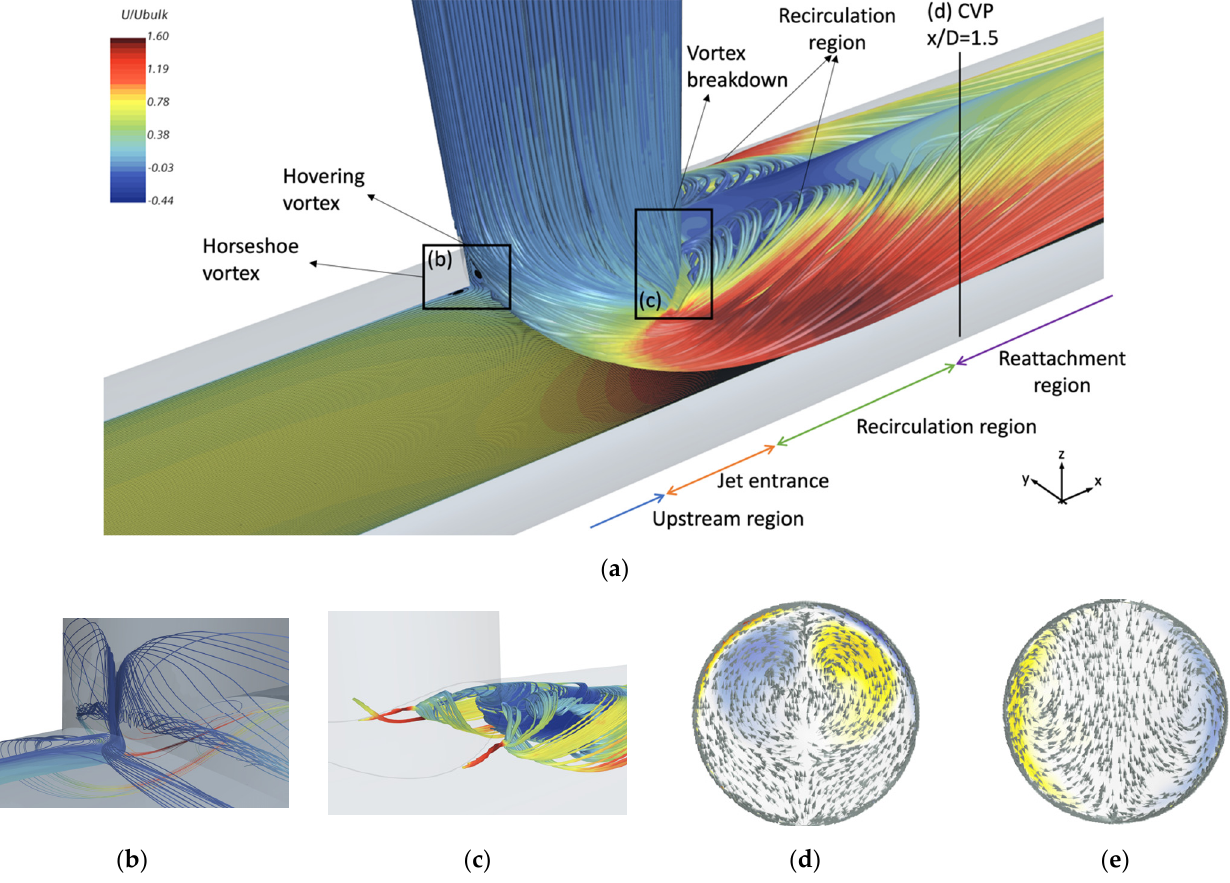
Figure 3. Mean flow structures ( a ), Horseshoe and hovering vortex ( b ), Vortex breakdown & tornado-like vortices ( c ), CVP at x / D = 1.5 ( d ), Second pair of vortices at x / D = 4 ( e ). For ( a – c ), streamlines plots are generated with mean velocity coloured by mean velocity magnitude; for ( d , e ), arrows plots are generated with in-plane mean velocity and the contours are coloured by mean streamwise vorticity.